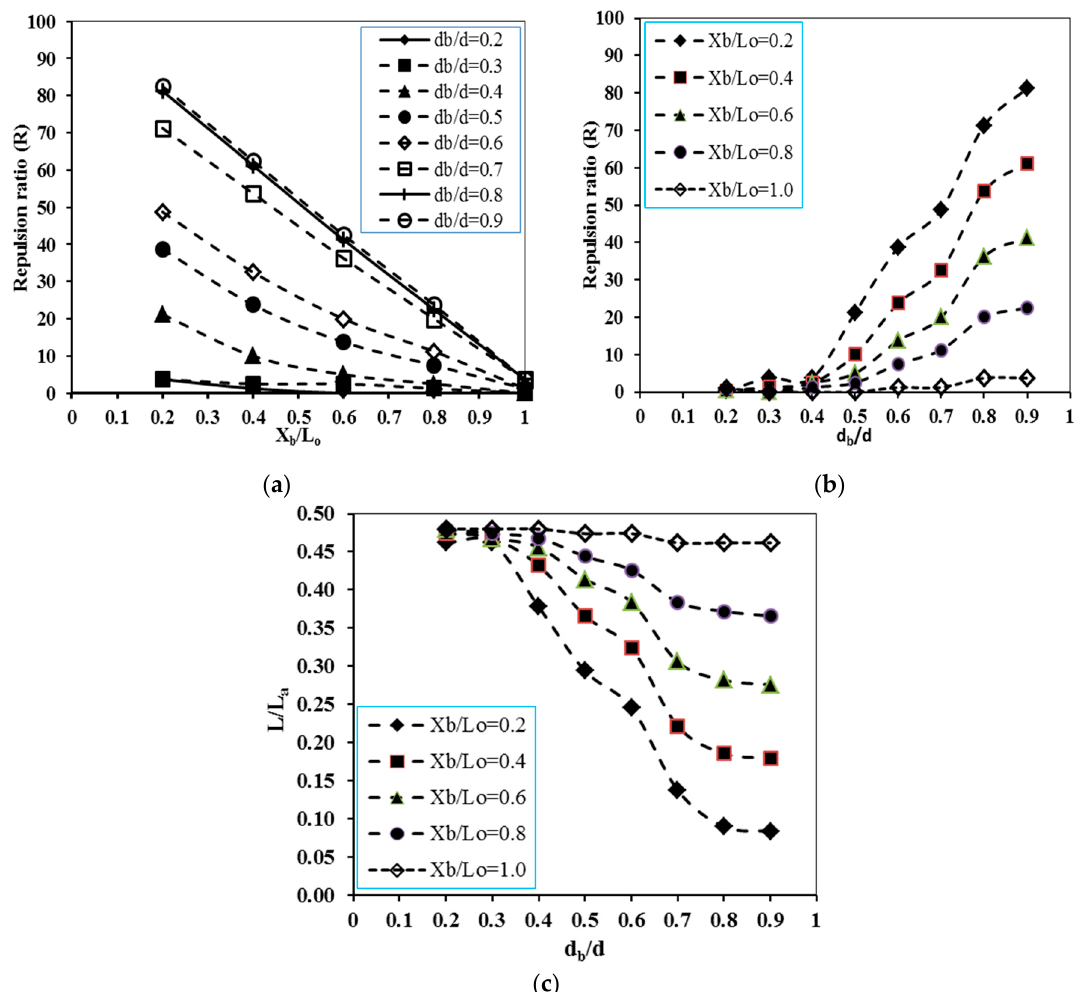
Figure 13. Relationship between the repulsion ratios of SWI in the Akrotiri aquifer with different values of ( a ) X b /L o , ( b ) d b /d, and ( c ) relationship between the SWI length ratio with different d b /d and of ( a ) X b / L o , ( b ) d b / d, and ( c ) relationship between the SWI length ratio with di ff erent d b / d and X b / L o X b /L o .